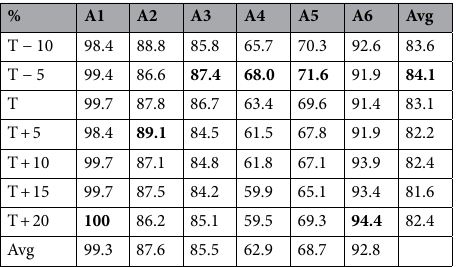
Table 6. Classification results for the masked phase data domain, with patent features and different threshold